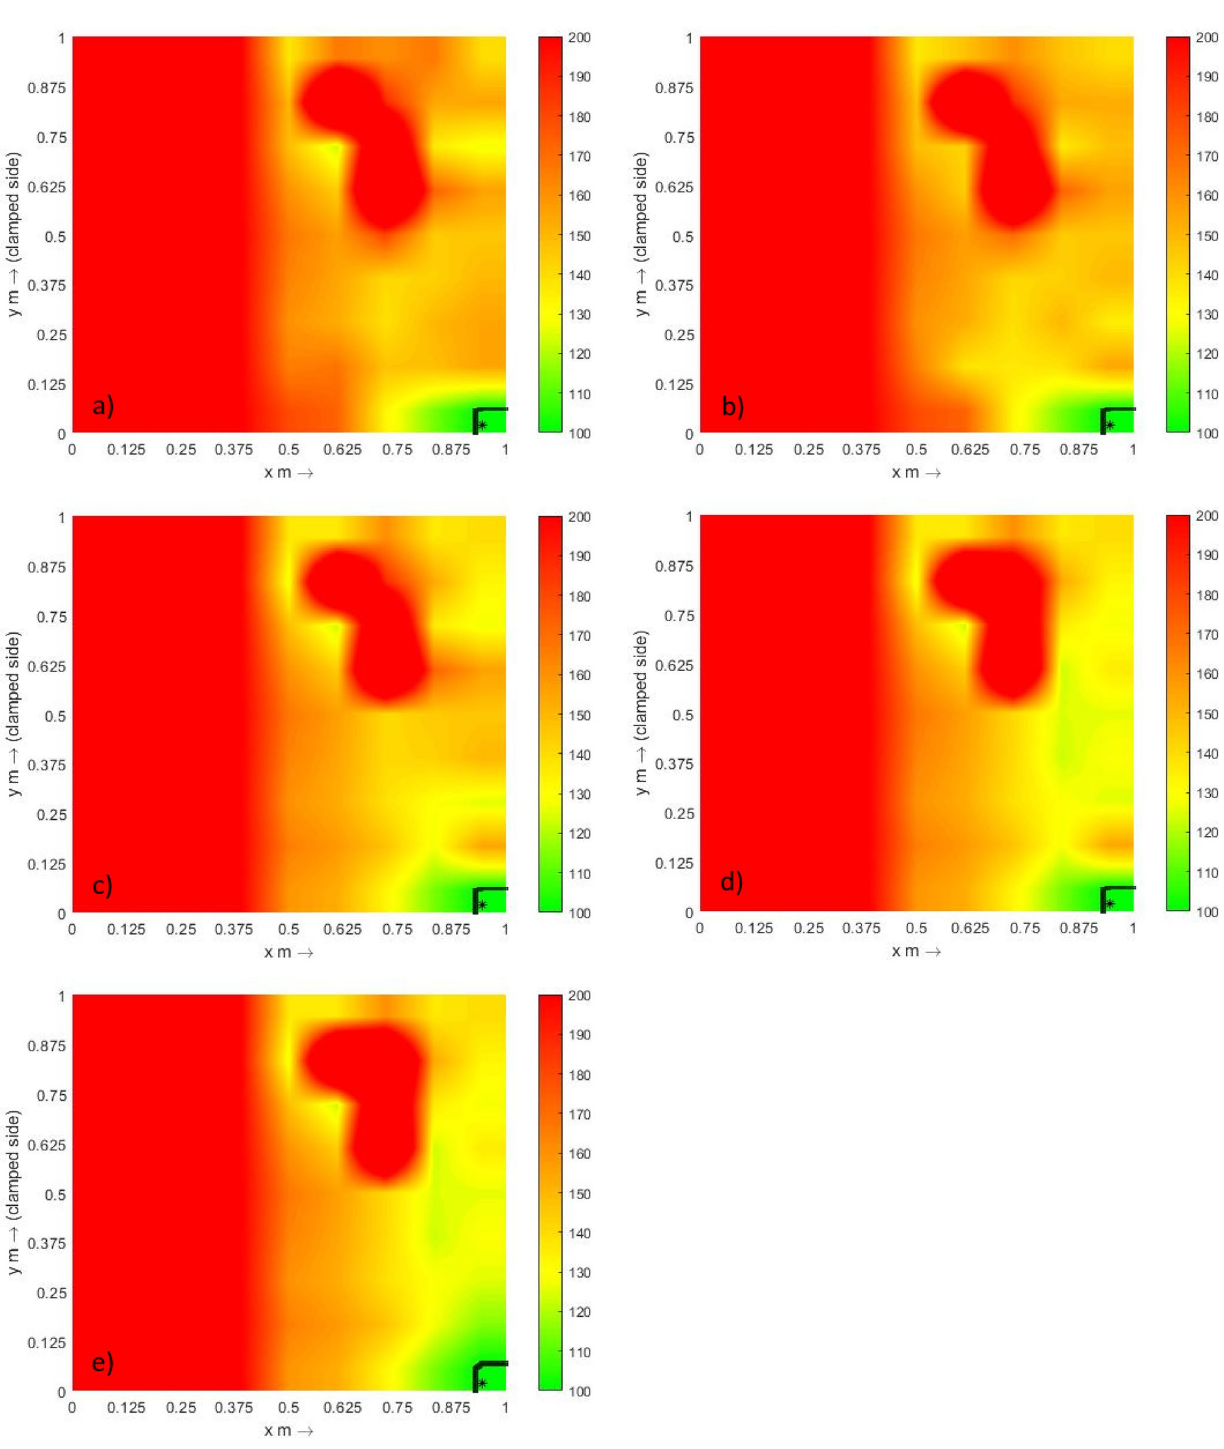
Fig. 15 Estimated region of the position of load applied for test point D using a finer grid with a deflection of a 5 mm, b 10 mm, c 15 mm, d 20 mm and e 25 mm. Asterisk marks the actual position of applied